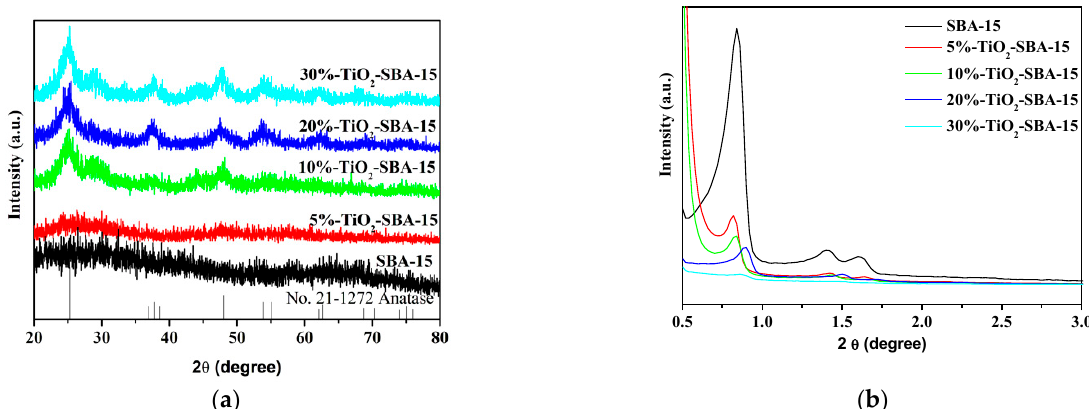
Figure 3. ( a ) XRD patterns of different TiO 2 loading amounts, ( b ) SAXS plots of different TiO 2 load- ing amounts. Table 1. Sample specific surface area and pore size for SBA-15 and different TiO 2 loading amounts.